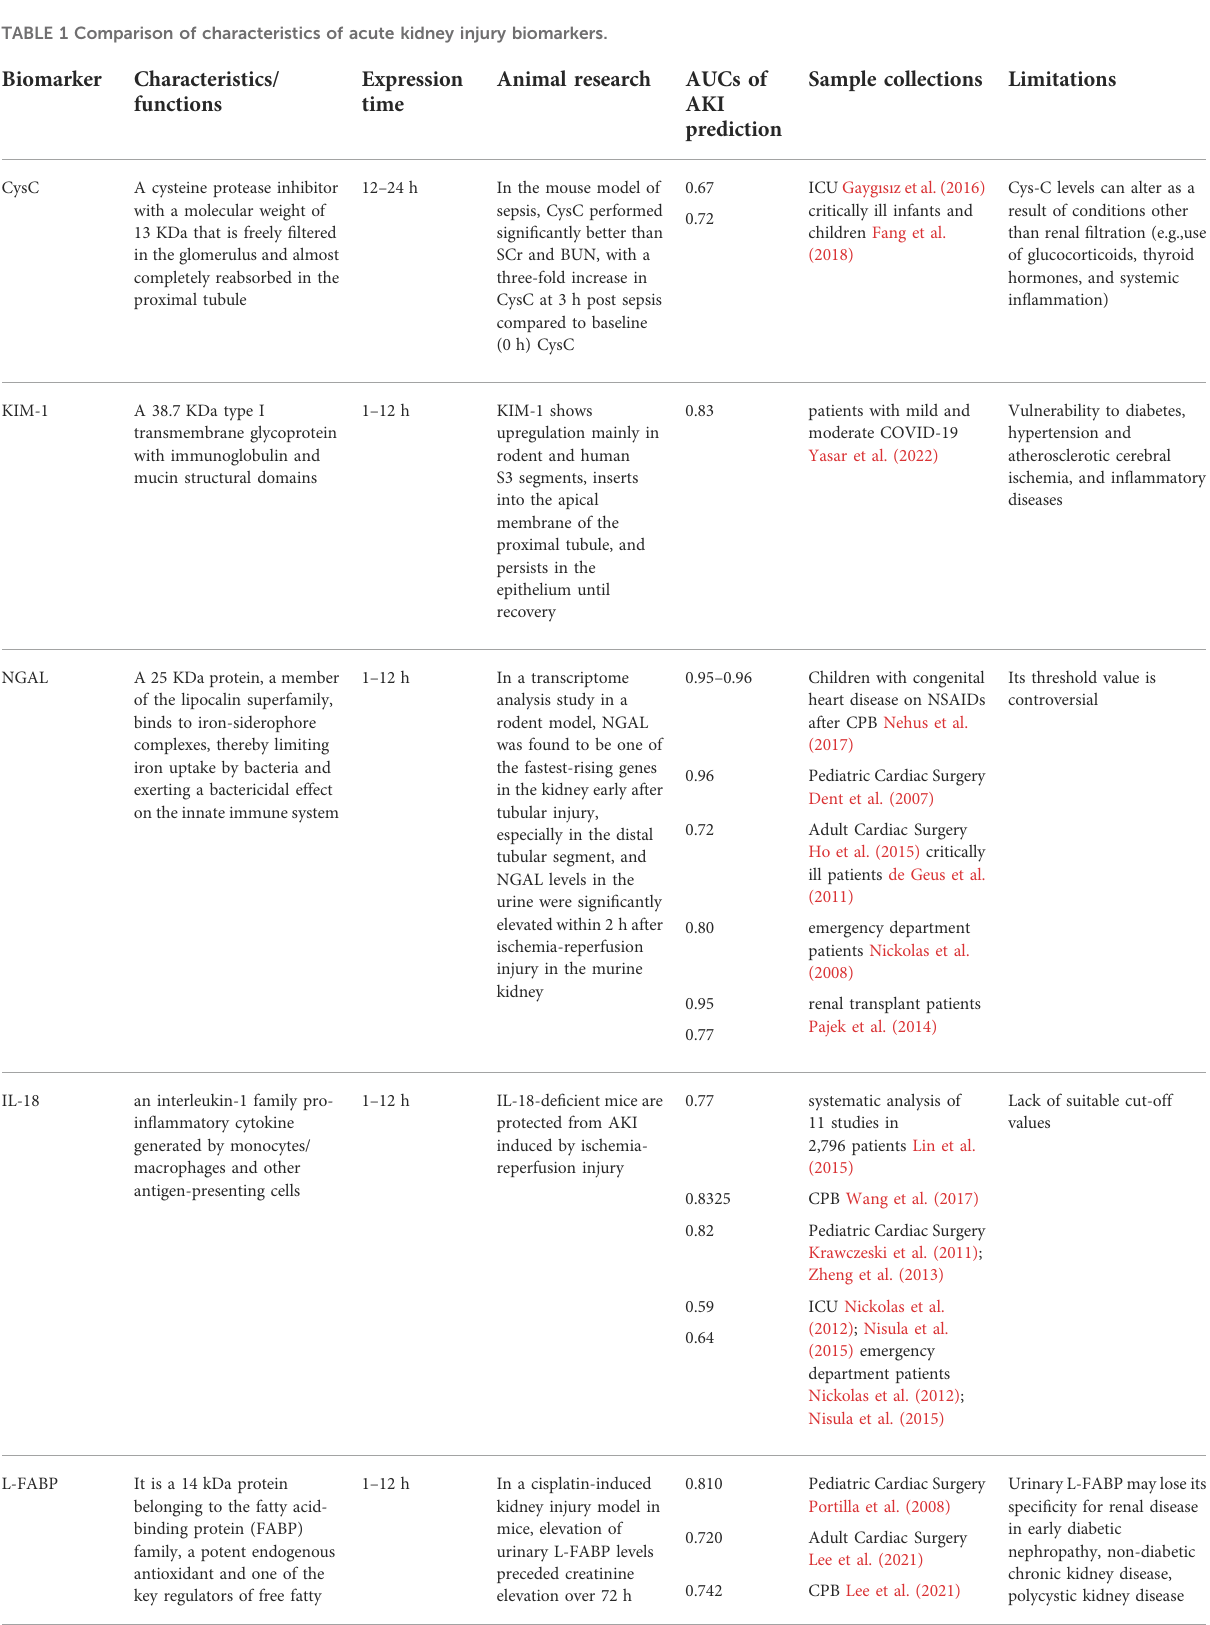
TABLE 1 Comparison of characteristics of acute kidney injury